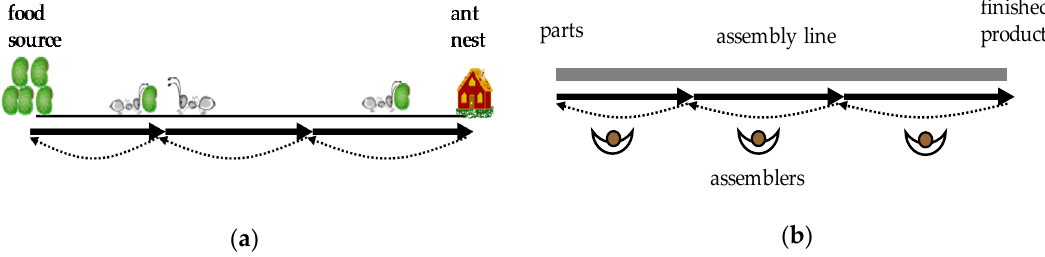
Figure 1. Bucket brigades (BBs): ( a ) cooperative food transport of ants in nature and ( b ) BB-based assembly cell.